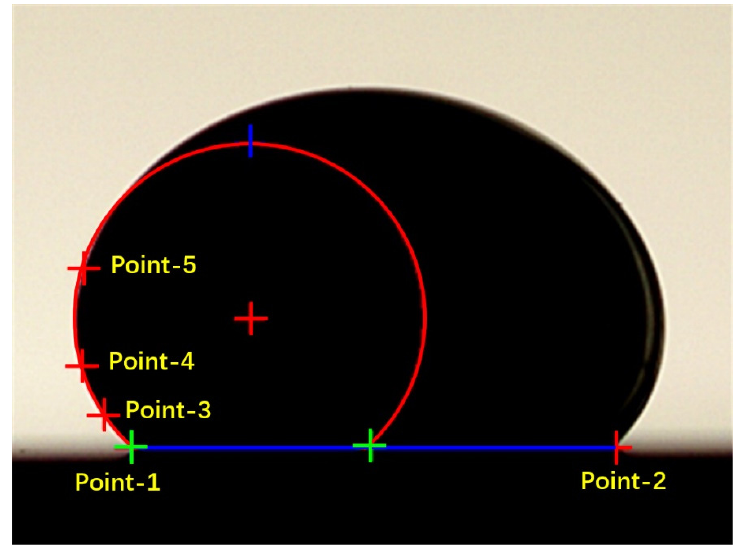
Figure 3. Image processing: an example of five-point fits [24].